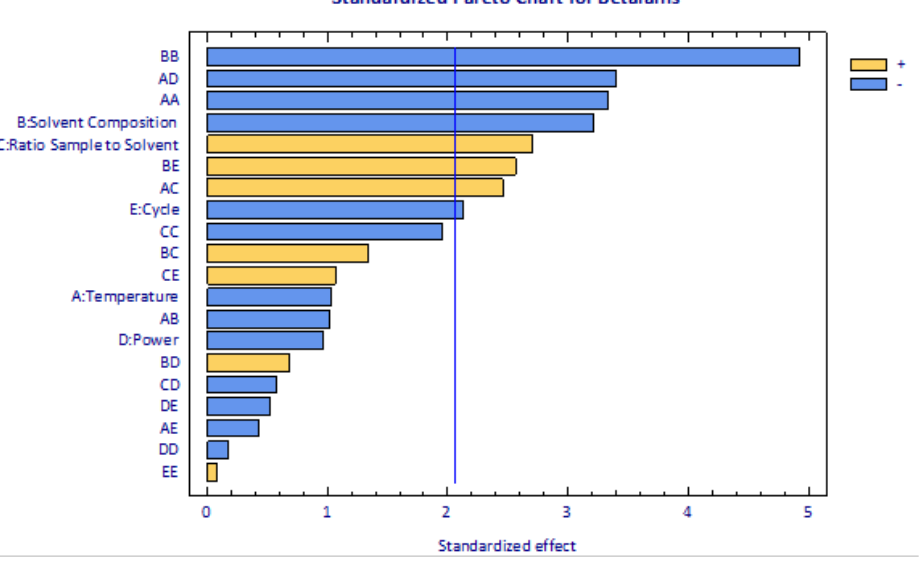
Figure 2. Pareto chart of the standardized effects from the variables in the extraction process. A: Temperature; B: Solvent composition; C: Ratio sample to solvent; D: Ultrasound power; E: Cycle.